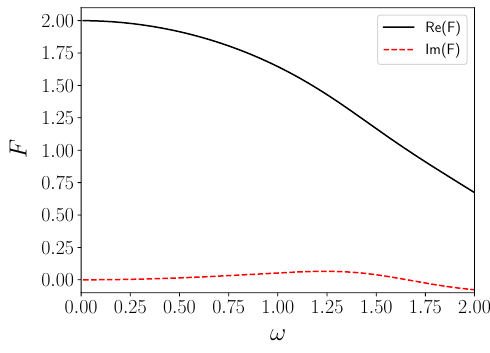
Figure 6 . Real and imaginary parts of the resonance form